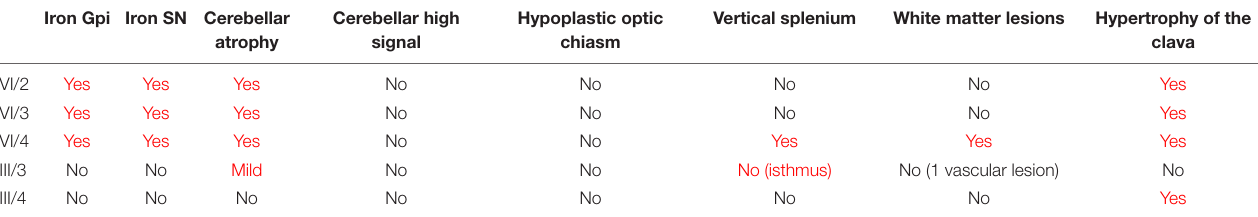
TABLE 1 | The results of the brain MRI.